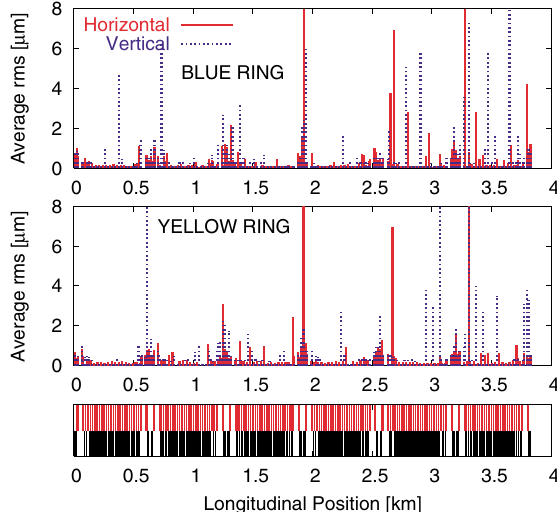
FIG. 14. (Color) Average rms observable versus longitudinal position of the BPM for run 2004.